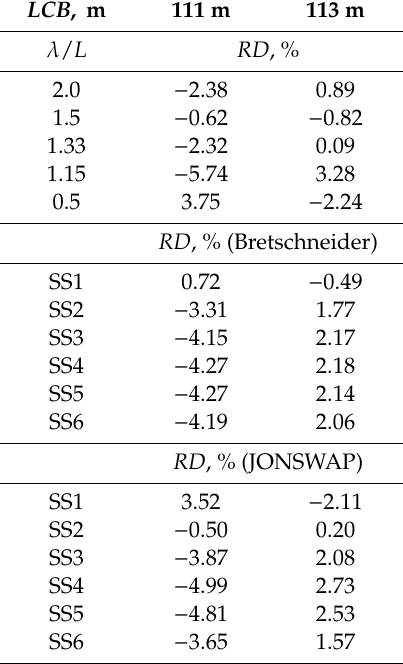
Table 6. Influence of the position of the longitudinal centre of buoyancy on added resistance in regular and irregular waves. LCB , m 111 m 113 m λ /